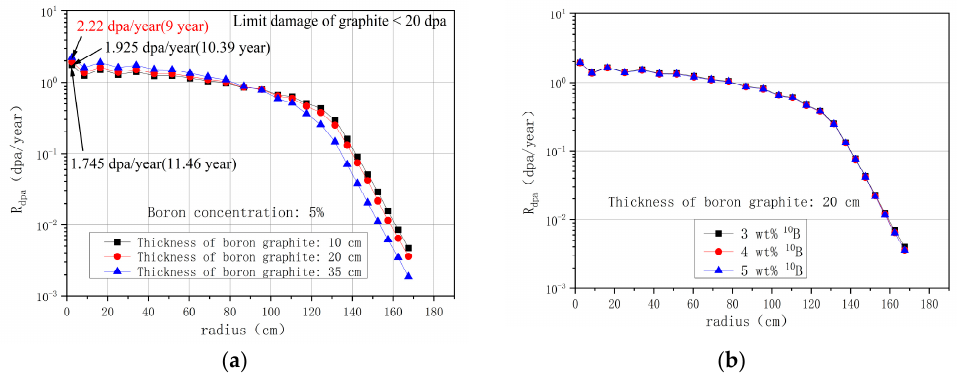
Figure 11. DPA in the graphite of ( a ) scheme D and ( b ) scheme E.